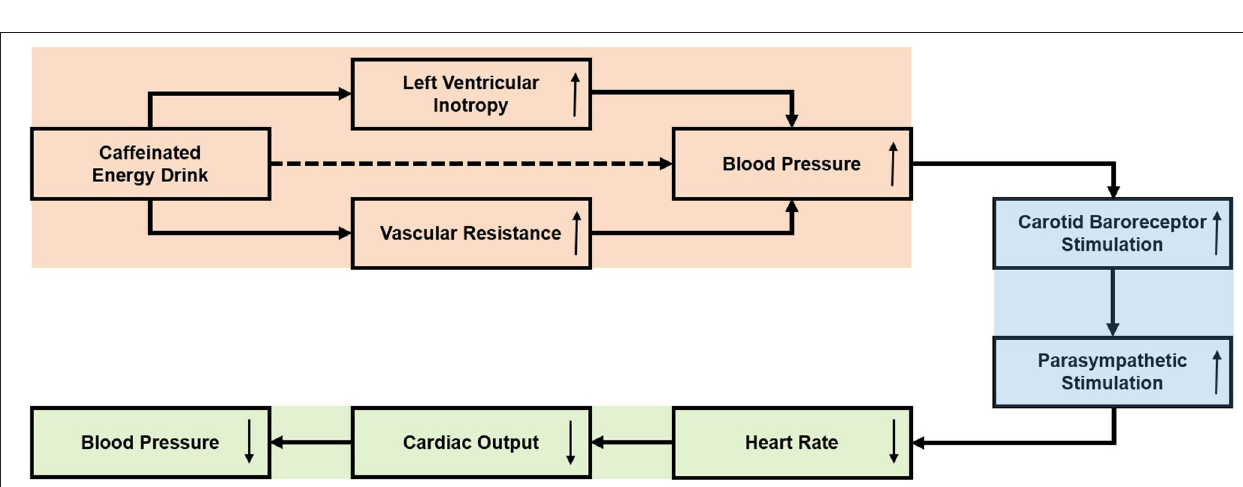
FIGURE 5 | Effects of caffeinated Energy Drinks on cardiovascular function: physiological